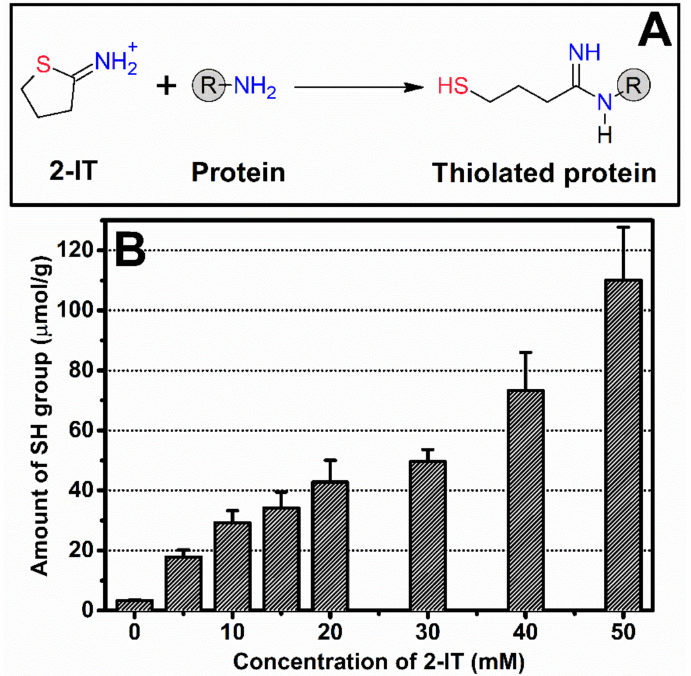
Figure1. ( A )Thiolationreactionofproteinusing2-iminothiolane(2-IT)toattachasulfanylbutanimidine group to a primary amine. ( B ) Amount of available sulfhydryl groups of thiolated silk fibroin (tSF) determined by the Ellman reagent assay as a function of 2-IT